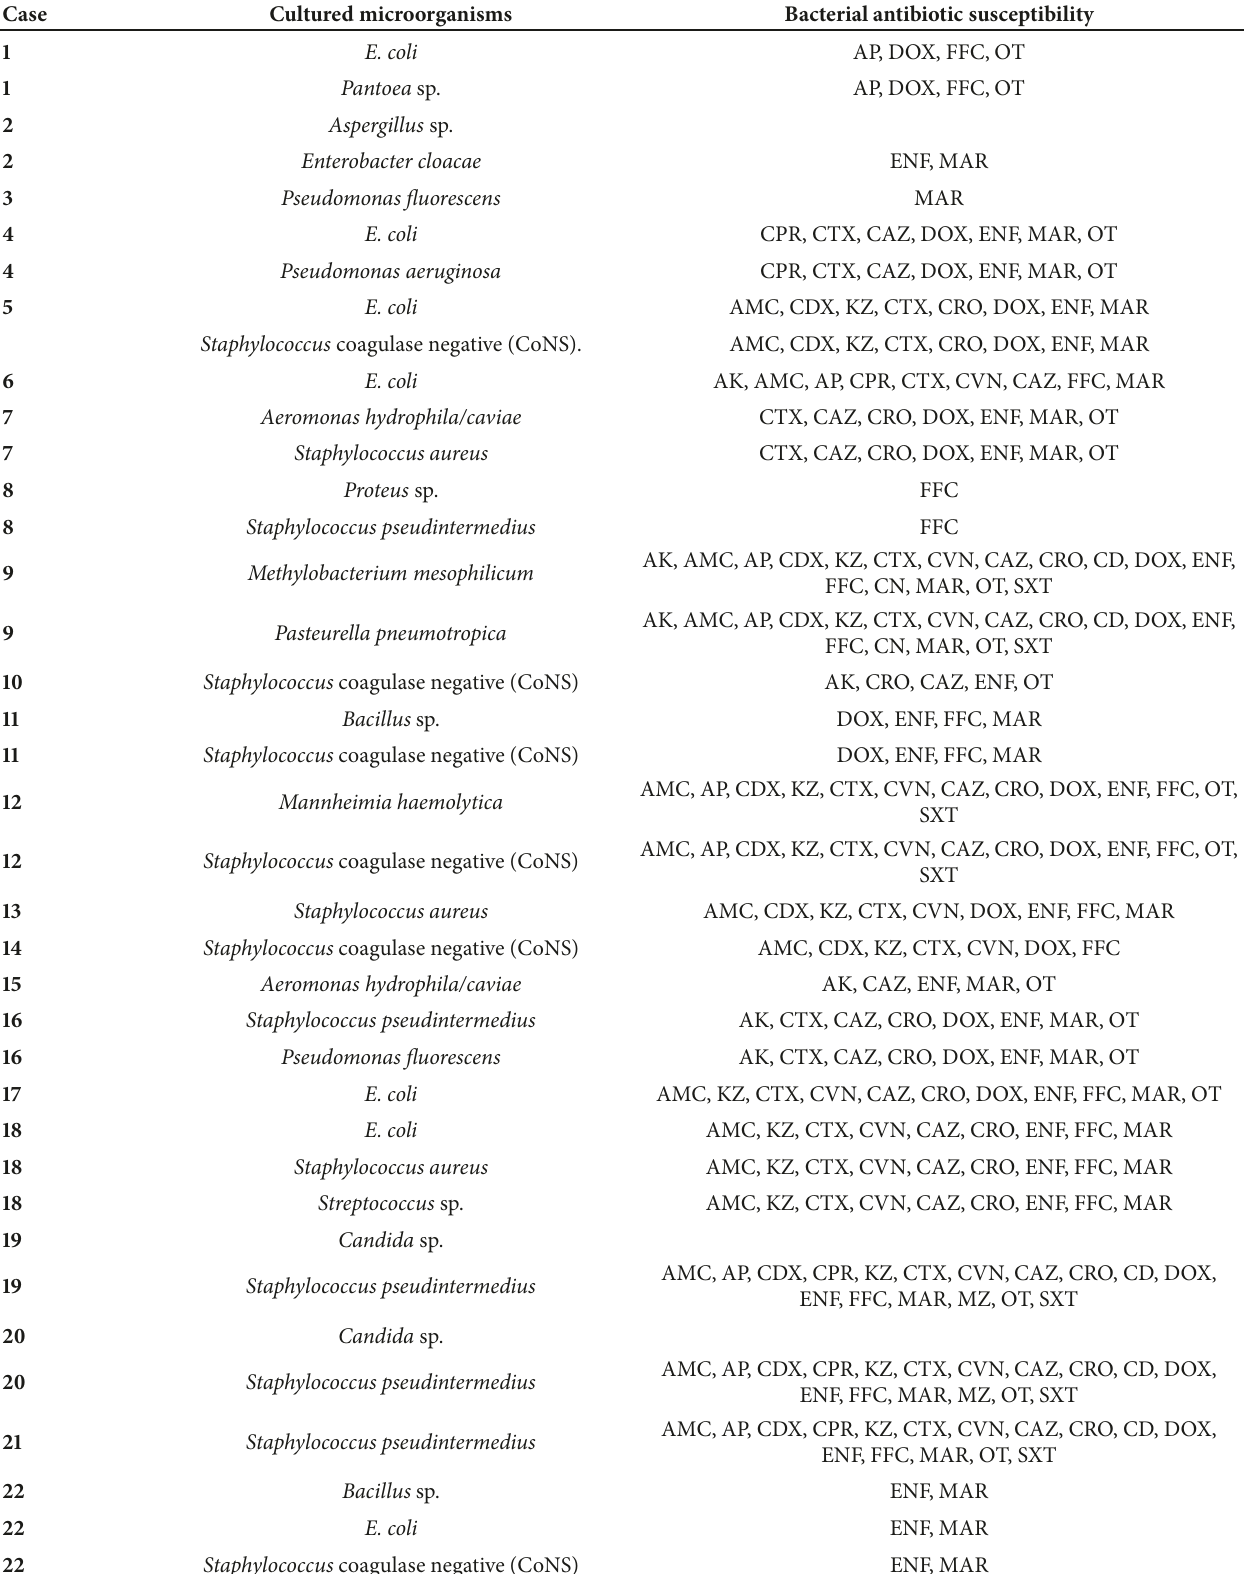
Table 3: Microbial isolates from vegetable foreign bodies extracted from upper respiratory tract and their antibiotic susceptibility.